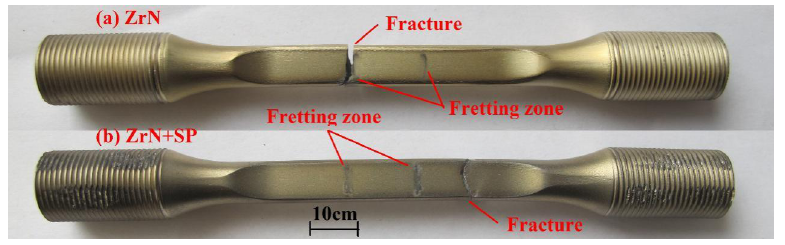
Figure 18. FF testing failure patterns of the ZrN and ZrN+SP specimens.